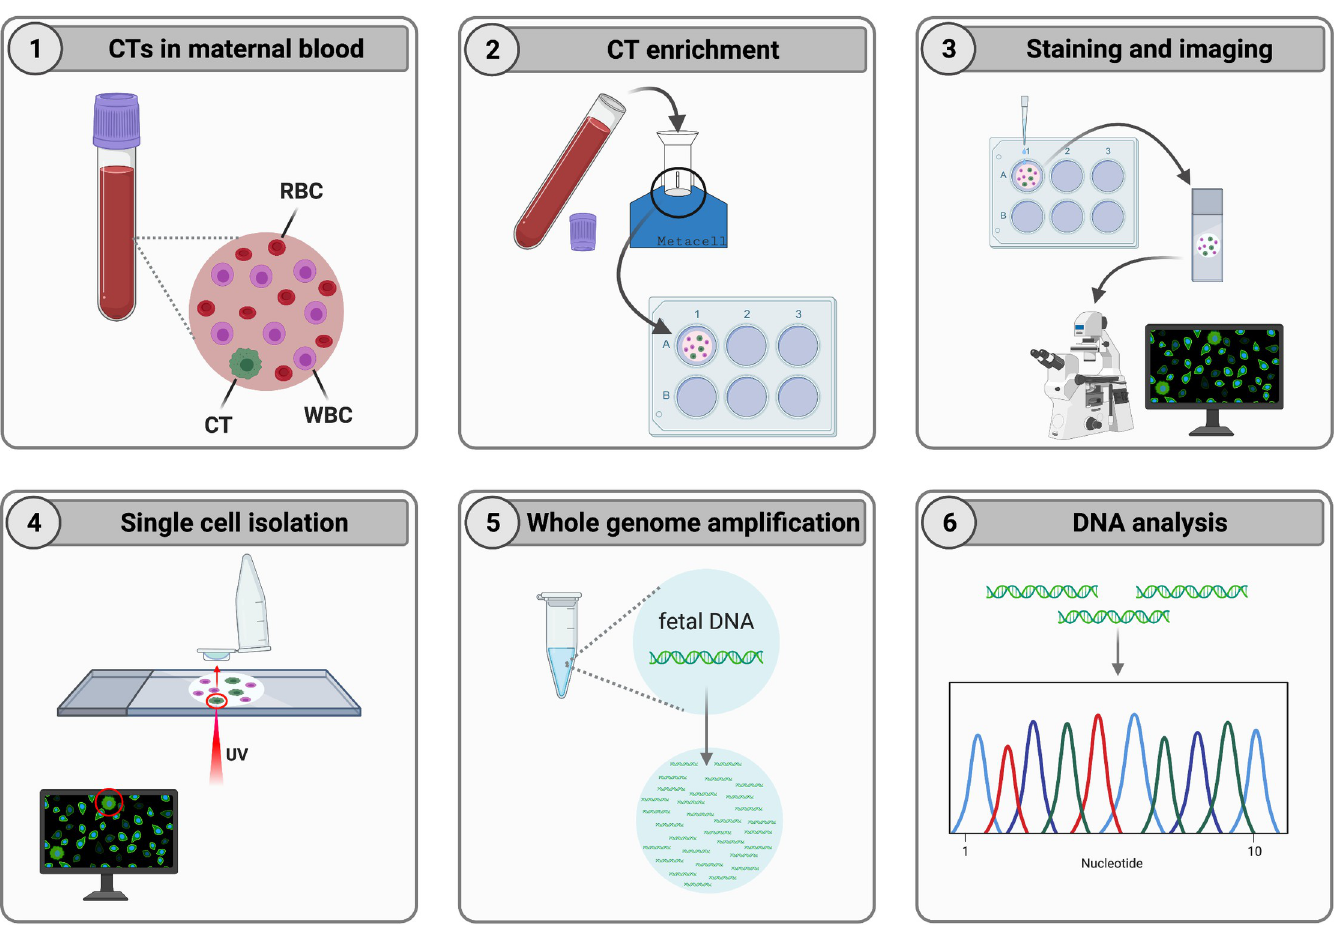
Fig 2. Metacell 1 CT enrichment and related procedures implemented in a cbNIPT workflow. (1) Maternal blood containing a low fraction of CTs, is collected at week 10 to 13 of gestation. (2) CTs are enriched using the size-based Metacell 1 technology. Larger cells, such as CTs, remain on the separation membrane. Optionally, the membrane with cells is further cultured to deplete more unwanted cells. (3) A fluorescent dye is added to the culture medium. Cells on the membrane are then visualized with an LCM fluorescence microscope. (4) Based on cytomorphology, cytochemical staining, or immunostaining, a single CT is selected and isolated with UV-LCM. (5) The genome of the single cell is then amplified. (6) Eventually, DNA analysis is